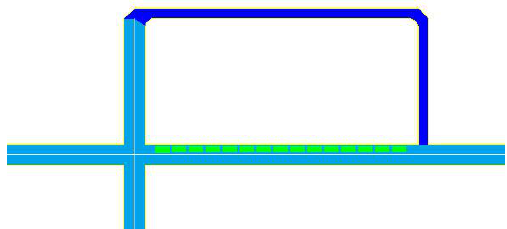
Figure 9. This figure shows a detour that was defined after the traffic jam was recognised. The detour can be used for leading ongoing traffic to escape the traffic